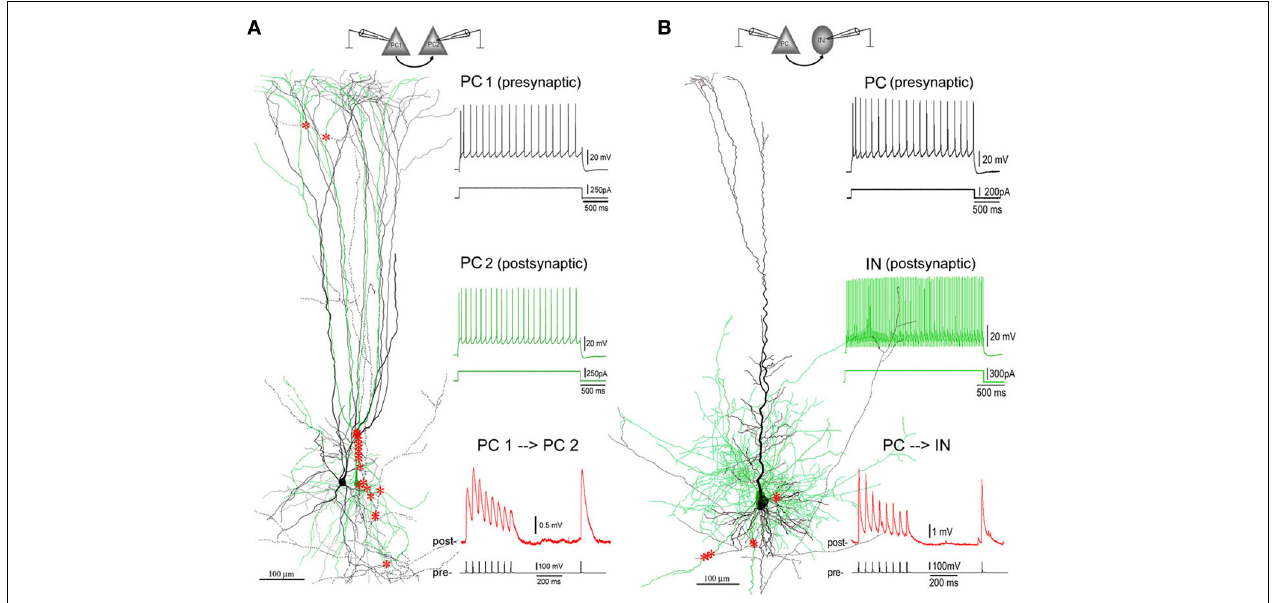
FIGURE 1 | Excitatory synapticconnectionsin layerV of PFC. (A) A facilitating (F-type)PC-PC connectionin layer V of thePFC of an 8-weeksold ferret. Left panel:3D computerreconstructionof the connection:Both pre- (PC1 in black) andpost-synaptic(PC2 in green)cells are complexPCsfeatured byanapicaldendritewithmultipleearly-bifurcatedmajorbranches.Atotalof20 putative synapsesare markedwith redstars ontothe basal, apical, obliqueand tuft dendritesof PC2. Right panel:Physiological responsesof pre-(upper,in black) and post-synaptic(middle,in green)cells were inducedbyinjectionsof depolarizationcurrentsinto their somata. Excitatory postsynapticpotentials (EPSPs,down,inred)wererecordedfromPC2bygivingbriefcurrentinjections